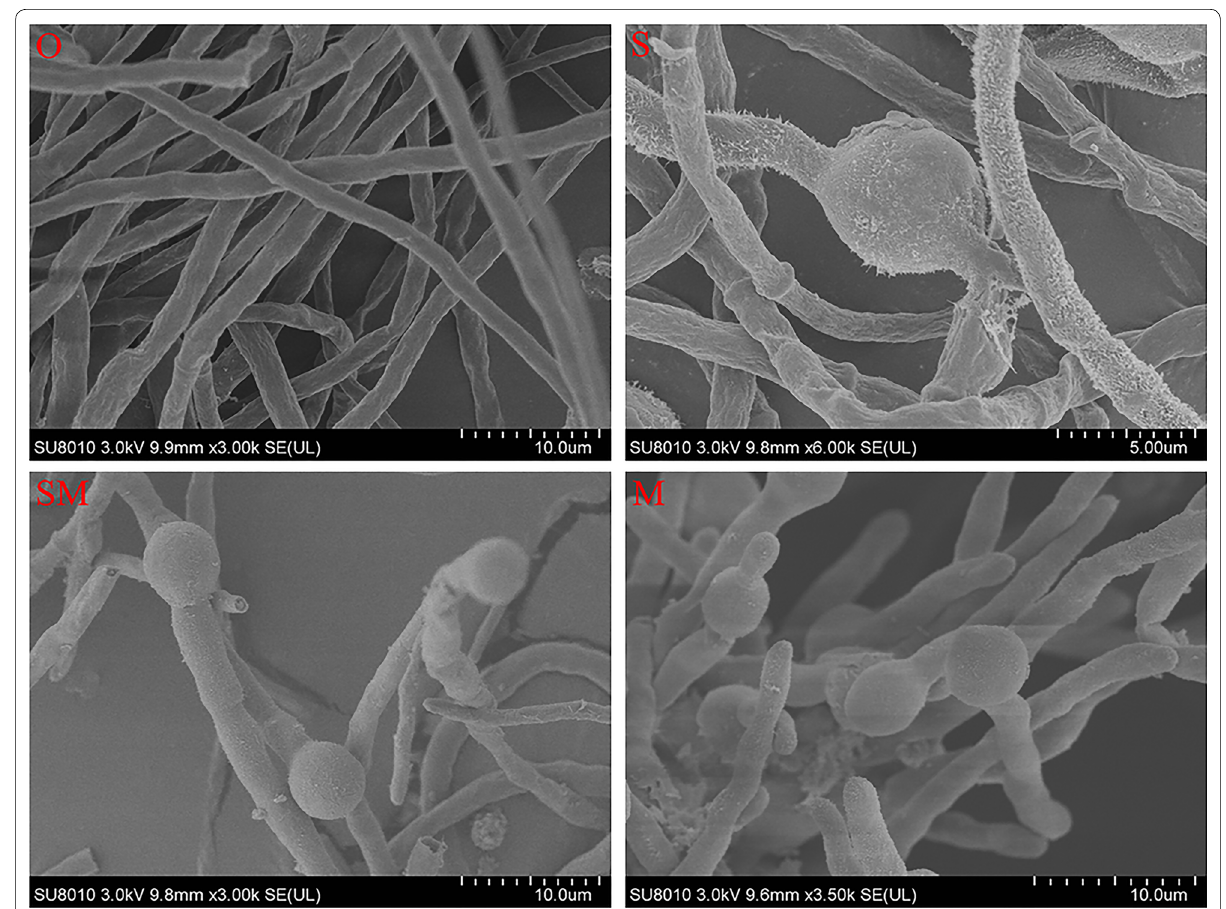
Fig. 4 The scanning electron microscope (SEM) graphs of A. niger sp. ZJUY cell surface in absence of both SVH and methanol (O), presence of SVH (S), presence of both SVH and methanol (SM), and presence of methanol (M)